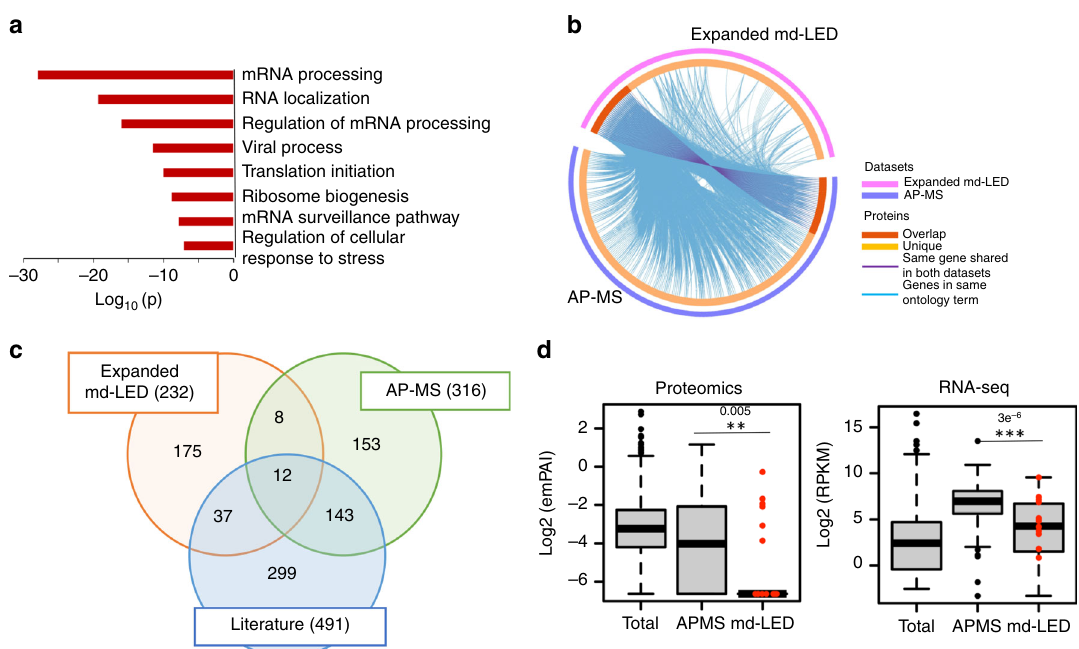
Fig. 3 md-LED facilitates identi fi cation of binders of low abundance. a GO enrichment analysis of genes that were identi fi ed to be interacting with NS1 through AP-MS. Metascape was applied for this analysis, which utilized the hypergeometric test and Benjamini – Hochberg P -value correction algorithm. b The Circos plot shows the overlap between proteins identi fi ed through expanded md-LED with AP-MS. On the outside, each arc represents the identity of gene list, using the same color code as shown on the legend. On the inside, the dark orange color represents the genes that appear in both methods, and light orange color represents genes that are unique to one method. Purple lines link the same gene that are shared by multiple gene lists. Blue lines link the different genes where they fall into the same ontology term. c Venn plot shows the overlap among the proteins identi fi ed through expanded md-LED, AP- MS, and literature. d The cellular abundance of identi fi ed protein binders were compared among total cellular proteins, md-LED, and AP-MS methods. Cellular abundance of each protein was quanti fi ed with a published cellular proteome database (PRIDE, project: PXD000418, left panel) and correlated transcript abundance was quanti fi ed through RNA-seq (right panel). The 14 cellular hits validated by Co-IP from md-LED method are marked in red. Center represents median, bounds of box represent fi rst and third quartile, whiskers represent median + / − 1.5 IQR. * P < 0.05, ** P < 0.01, *** P < 0.001 (two-tailed Wilcoxon rank-sum test, the exact P -value is labeled on the fi gure). Source data for b and c is provided in Supplementary Data 3. Source data for d is provided in Supplementary Data 2 and Source Data fi